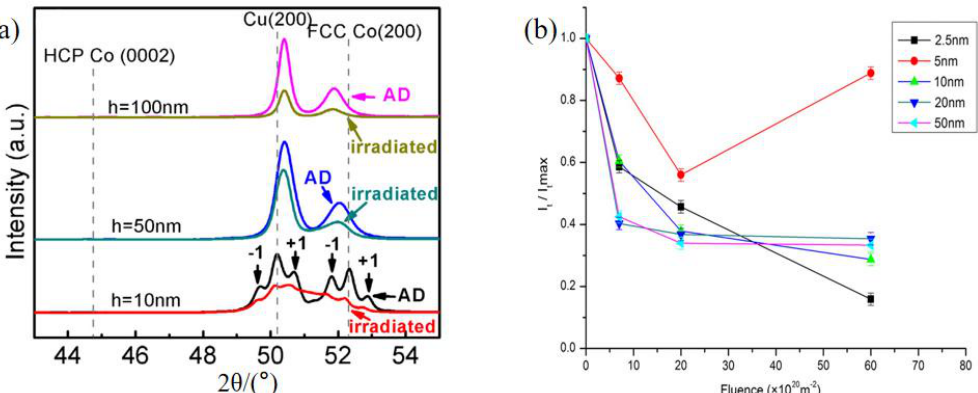
Figure 10. XRD patterns of ( a ) Cu/Co multilayer films with different layer thicknesses after He irradiation at 6 × 10 20 ions/m 2 [76]. ( b ) Evolution of the integrated intensity of diffraction in the region of 38°–45° observed in Cu/W multilayer films with different layer thicknesses under different doses of He irradiation. The region is mainly related to W (110) and Cu (111), as shown in Figure 8a. They show an overall trend of improving amorphization resistance with decreasing layer thickness [4]. Reprinted with permission from [76] Elsevier 2015, [4] Elsevier 2011.